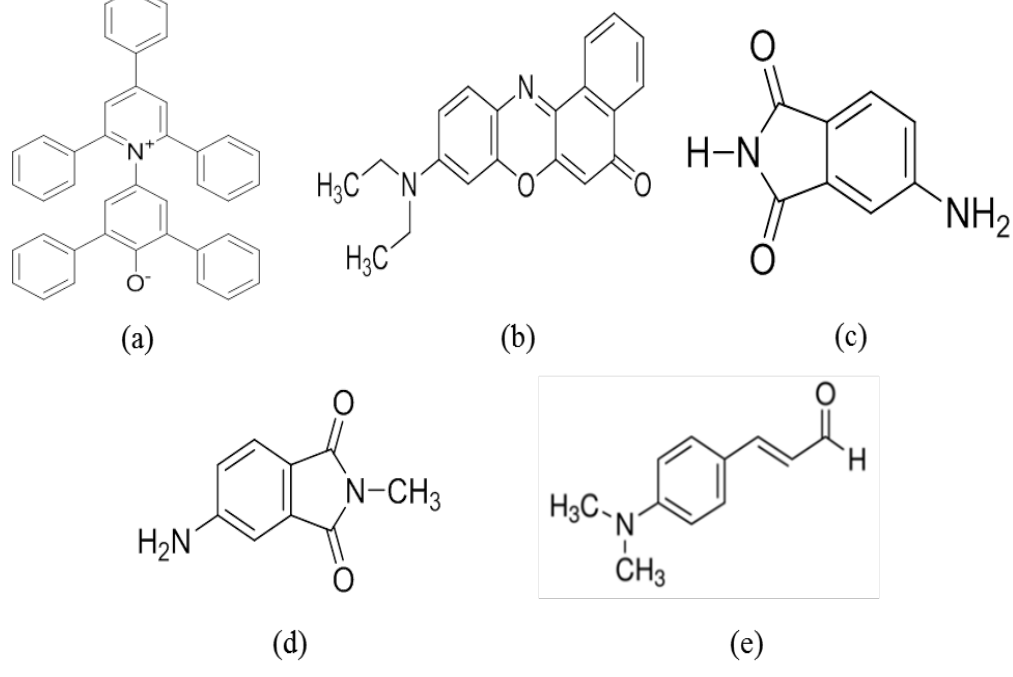
Figure 3. Molecular structure of solvatochromic dye: ( a ) Reichardt’s dye; ( b ) Nile red dye; ( c ) AP dye; ( d ) 4-ANMP dye; and ( e ) DMACA dye.